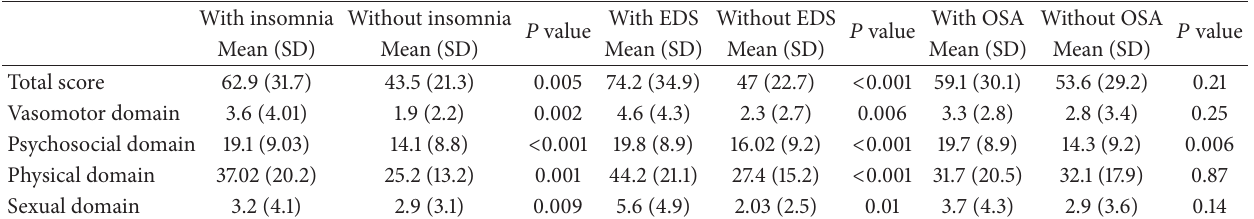
Table 3: Total score and mean (SD) MENQOL ∗ subscale score in relation to insomnia, EDS ∗∗ , and OSA ∗∗∗ . With insomnia Without insomnia 𝑃